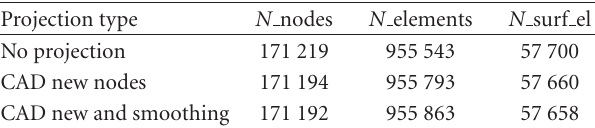
Table 3: Grid sizes for CAD projection after 1 adaptation step with 16 processors. ONERA M6